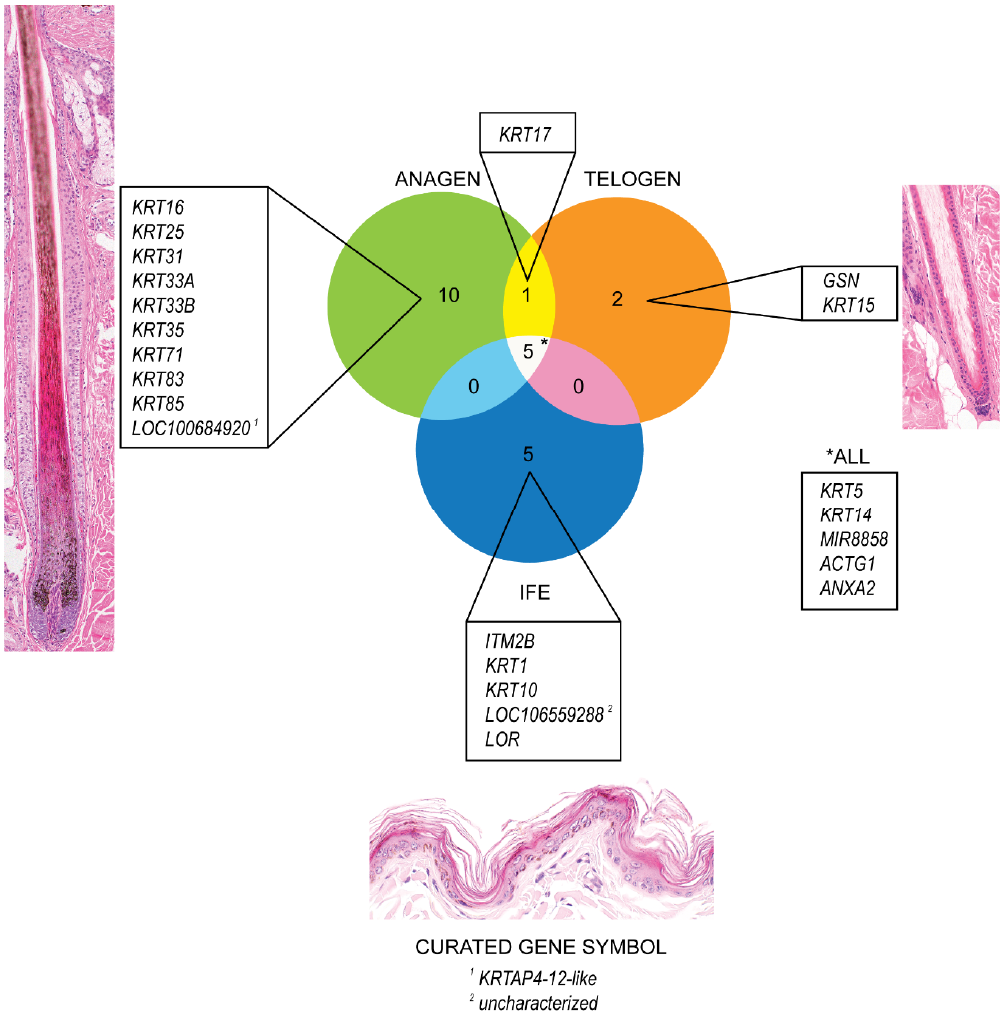
Figure 1. Venn Diagram depicting the most strongly expressed genes (average normalized counts > 5000) in telogen and late anagen canine hair follicles and the interfollicular epidermis, respectively. Genes with the highest expression in each group (late anagen, telogen and interfollicular epidermis) and those which are expressed in more than one group are outlined. Table 1. Expression levels of 92 selected genes. Preselected hair cycle-associated, hair follicle structure-associated, stem cell-associated, immune function-associated and epidermal structure-associated genes are listed, and the expression levels based on the average TPM normalized values in telogen, anagen and interfollicular epidermis samples are depicted. Darker colors represent higher expression levels (average normalized counts ≥ 400), lighter shades of blue represent intermediate and low expression levels (average normalized count of ≥100 and <400 and ≥10 and <100, respectively). White boxes represent very low expression of genes (average normalized counts < 10).